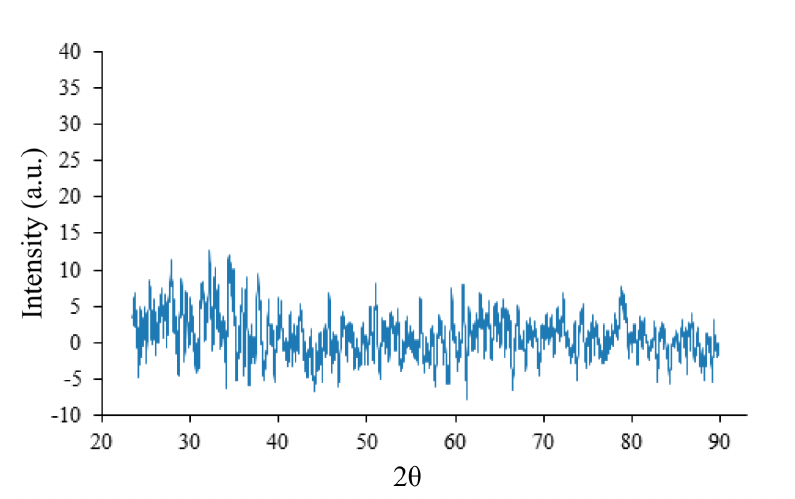
Figure 8. XRD of the sample with no